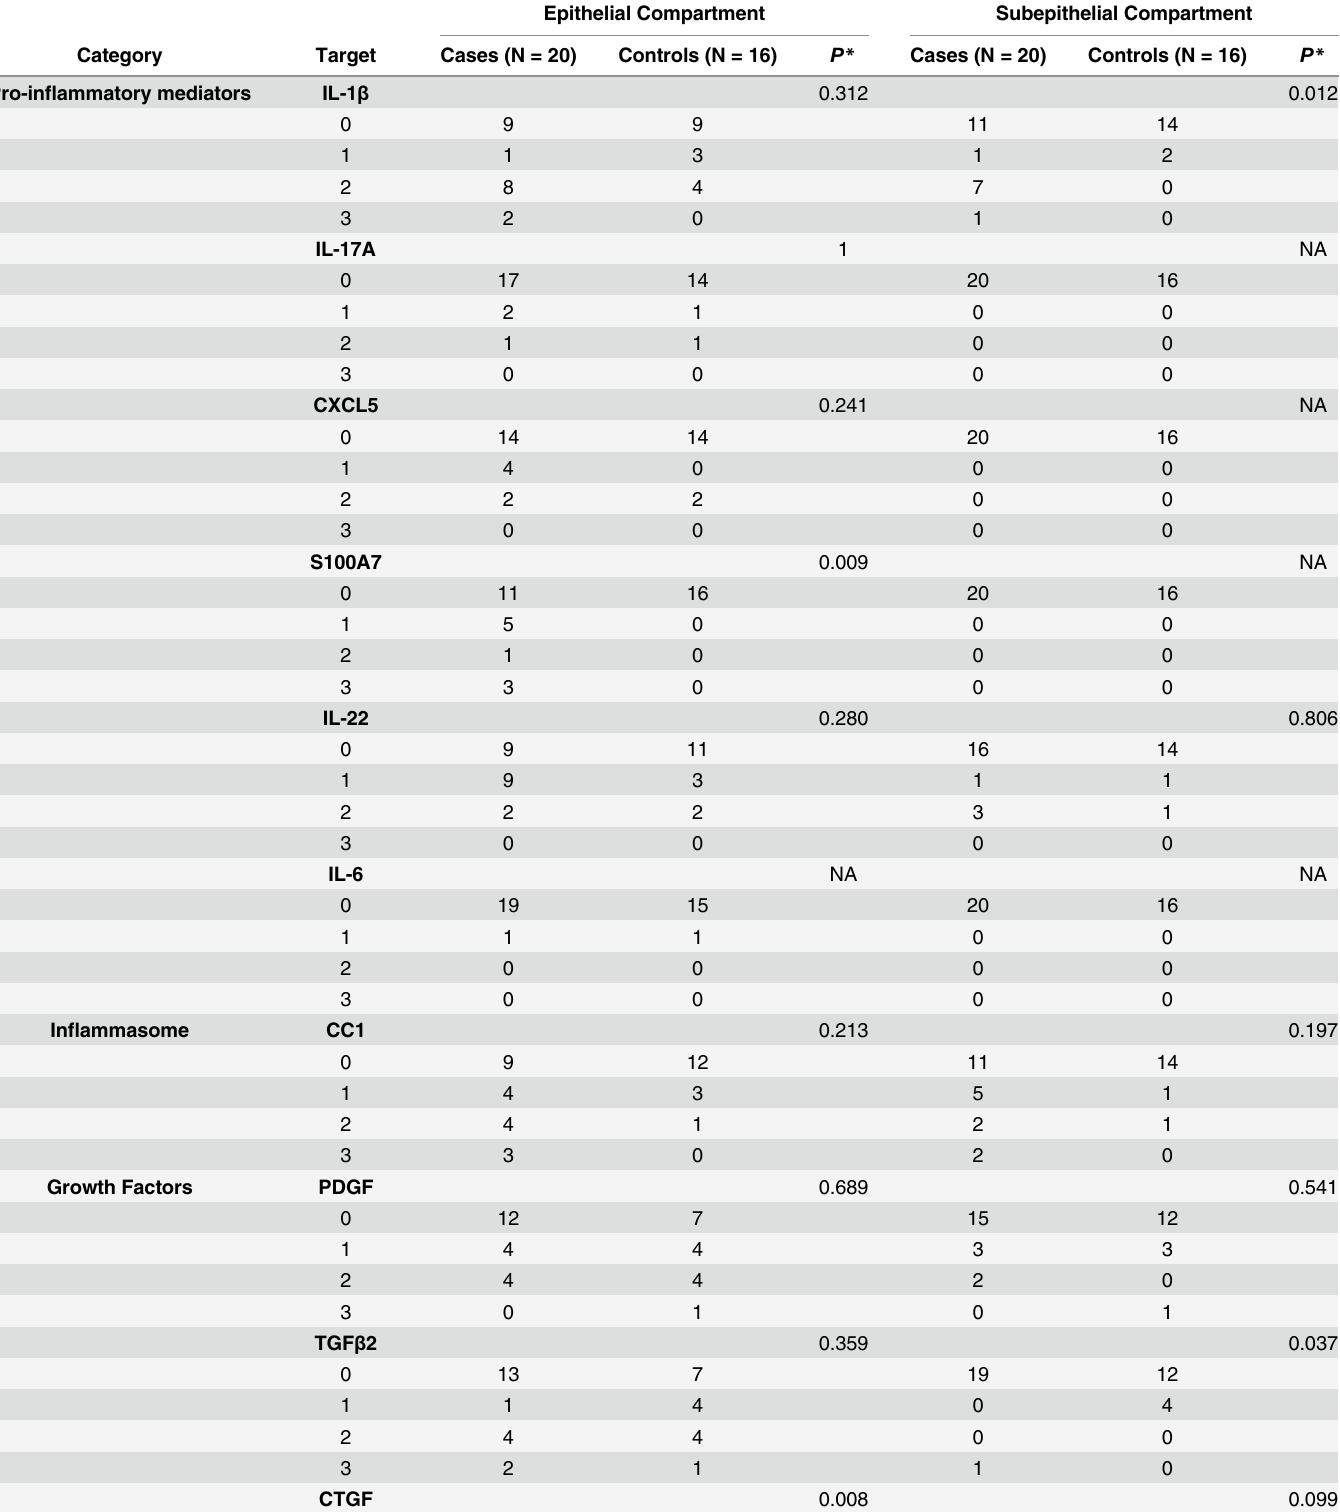
Table 3. Expression of specific molecular markers in the epithelial and subepithelial compartments by